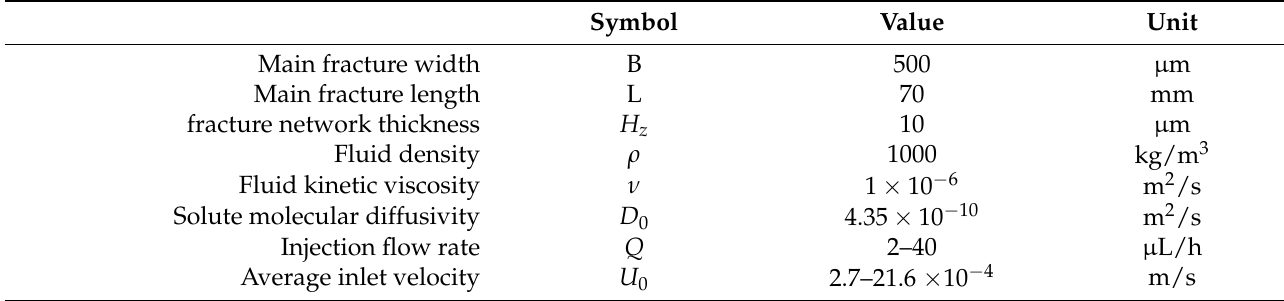
Table 3. Properties and experimental